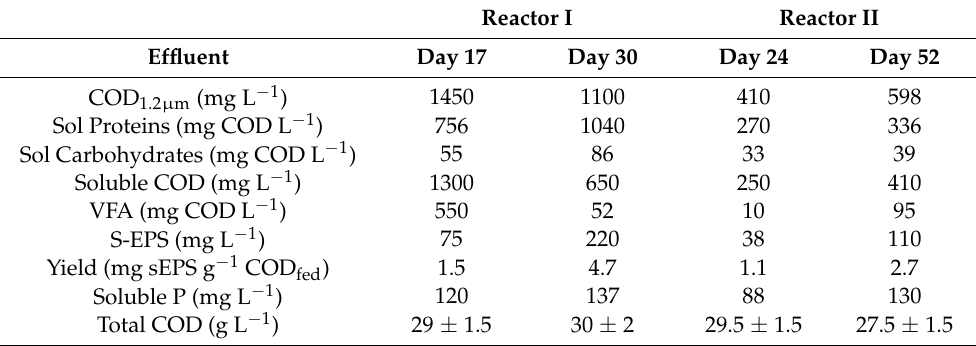
Table 2. Characteristics of effluent produced in Reactor I and Reactor II, in two different sampling